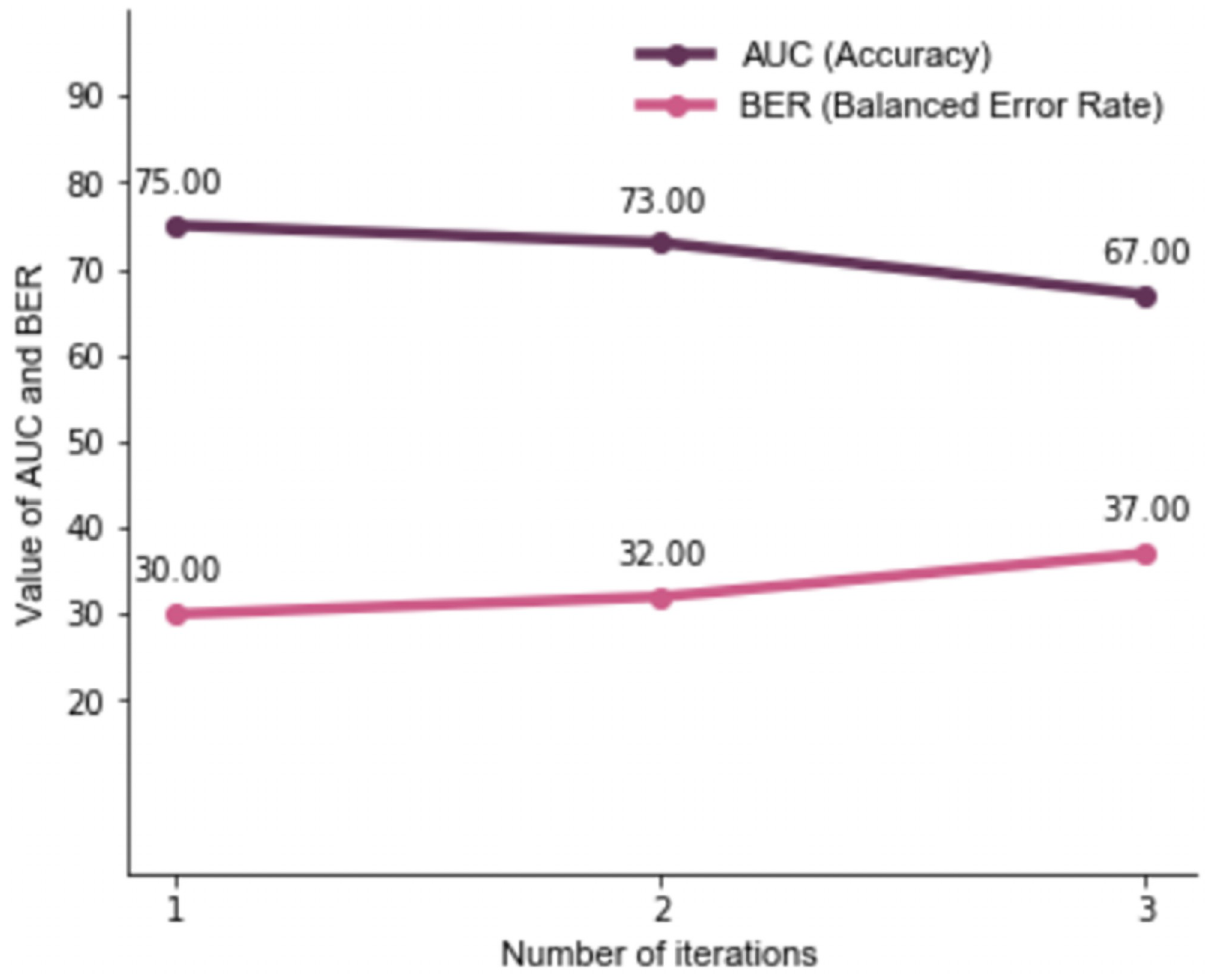
Fig 1. Accuracy (AUC) and balanced error rates (BER) for models with help-seeking from anyone as outcome.